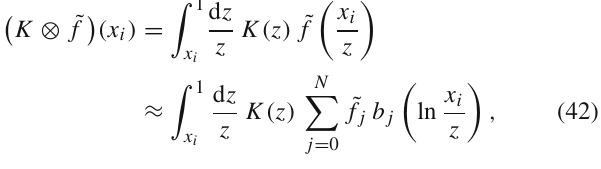
Fig. 9 Comparison of the relative integration accuracy (solid) and its estimate (dashed) for Clenshaw–Curtis (red) and Gauss–Kronrod (green) quadrature. The considered integrals are the truncated Mellin moments M i ( j ) of the test functions f i ( x ) with i = 2 , 3. For both methods we use two subgrids [ 10 − 9 , 0 . 2 , 1 ] ( 41 , 31 ) with the appropriate